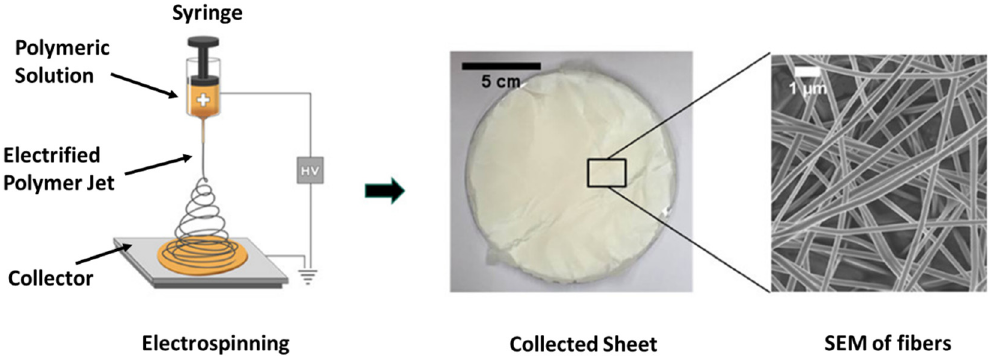
Figure 6. Schematic diagram of electrospinning technique. Modified from [30]: Designing Solutions for Electrospinning of Poly(ionic liquid)s. Macromolecules, 52, 5223–5230. Copyright (2019) with permission from American Chemical Society. Further permissions related to the material excerpted should be directed to the ACS.